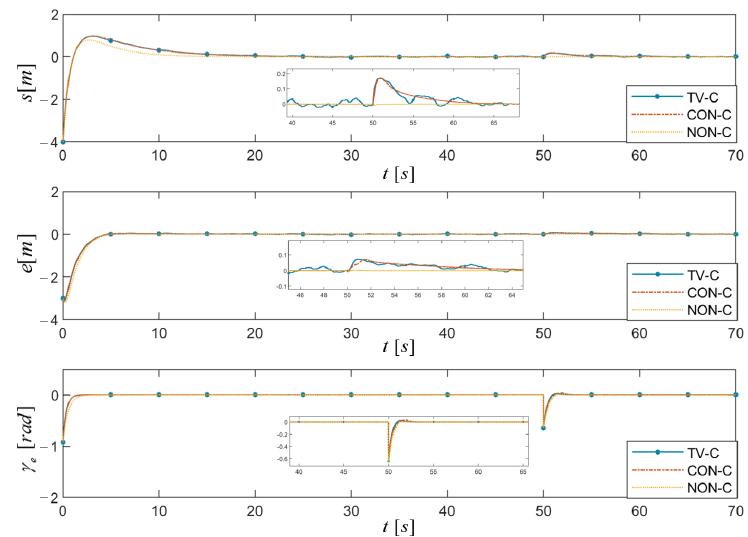
Figure 9. The tracking errors with NAITSMC methods under the influence of different currents.